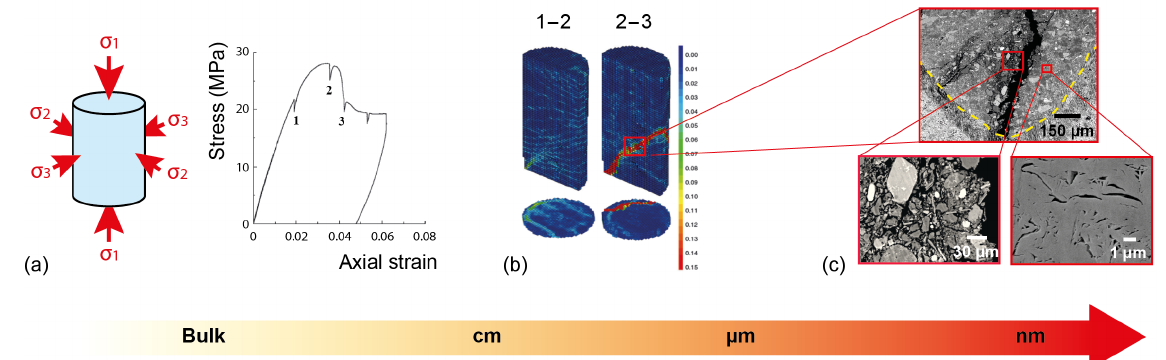
Figure 1. Drawing of the experimental concept used for the investigation of experimentally deformed fine-grained mudrocks from bulk scale to nanometre scale. The example is based on (a) a triaxial deformation test (10MPa confining pressure) performed on a cylindrical Callovo–Oxfordian Clay, (b) volumetric DIC on X-ray microtomography images to follow displacement fields (after Lenoir et al., 2007), and (c) SEM imaging on high-quality cross sections prepared by BIB. (a) Steps when X-ray microtomography images were acquired are indicated by 1, 2 and 3. (b) Deformation increments between steps 1 and 2 and steps 2 and 3 are indicated by 1–2 and 2–3